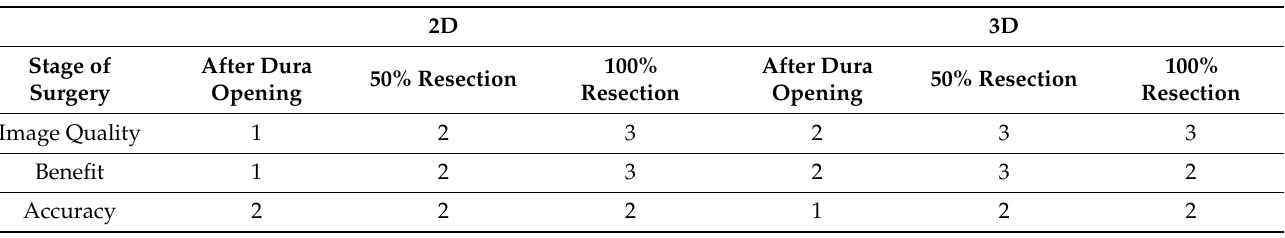
Table 1. Likert scale ratings reported for the frontal left WHO II Oligodendroglioma surgery presented in the text (1 = very good, 2 = good, 3 = fair).